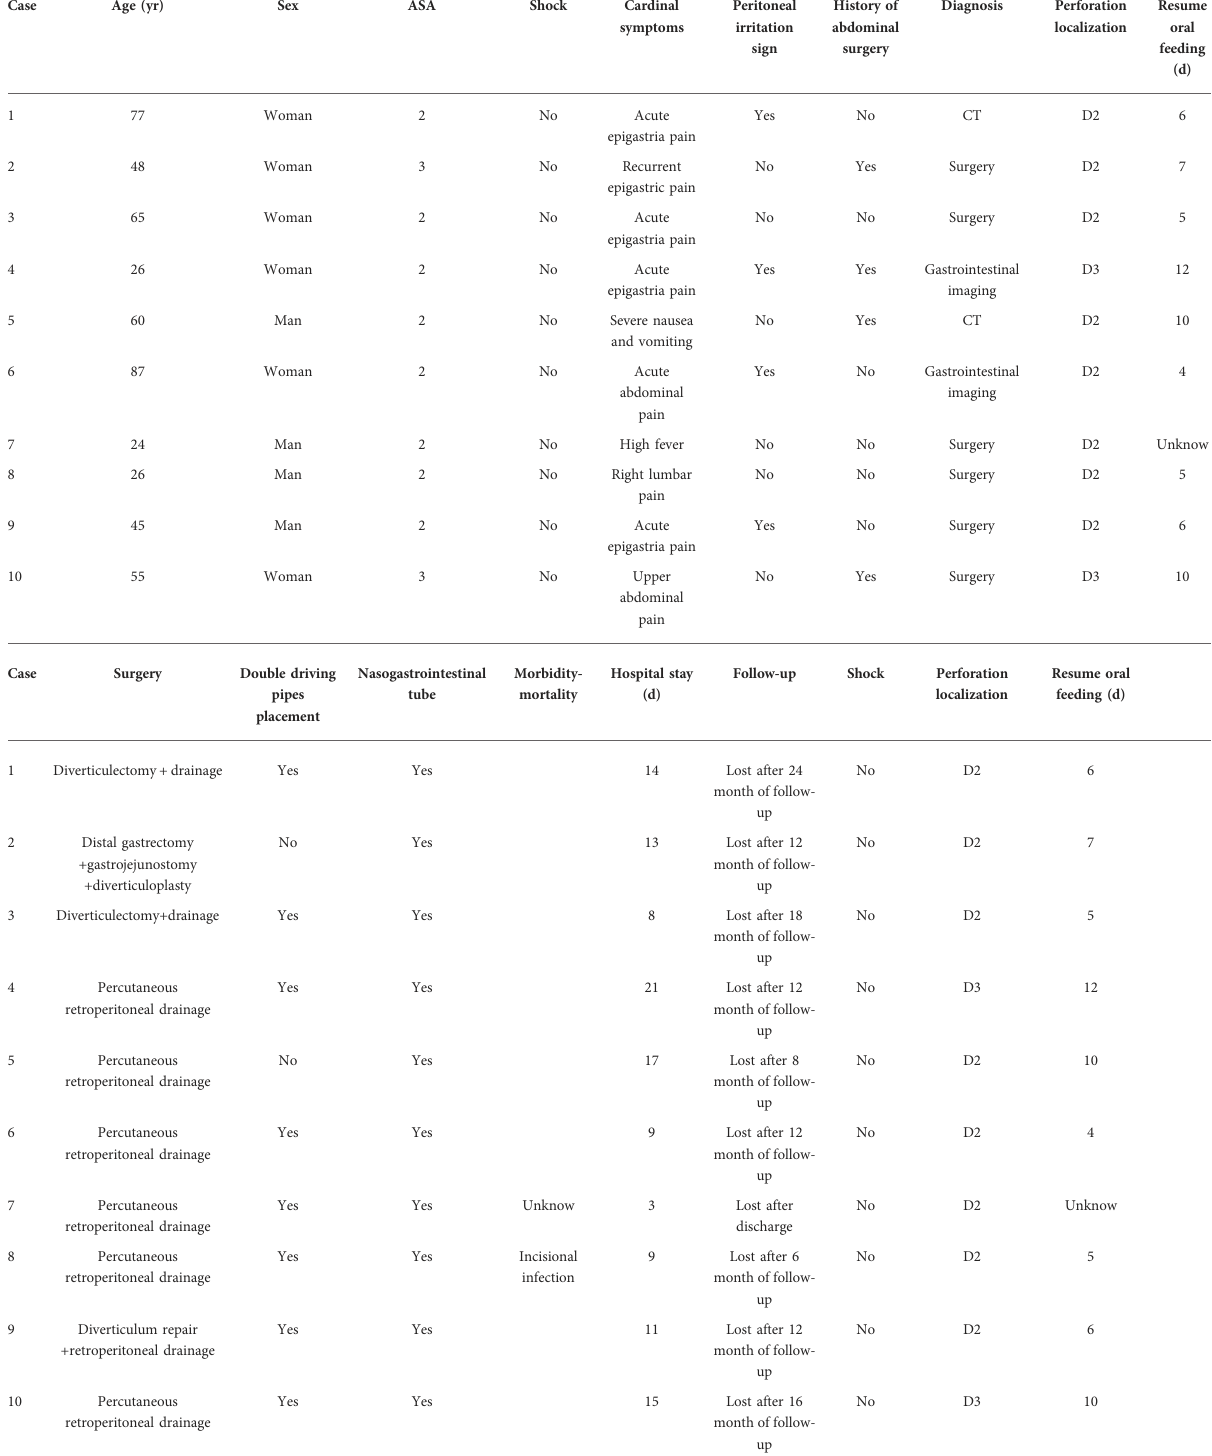
TABLE 1 Patient characteristics, treatment modalities, and prognosis. Case Age (yr) Sex ASA Shock Cardinal